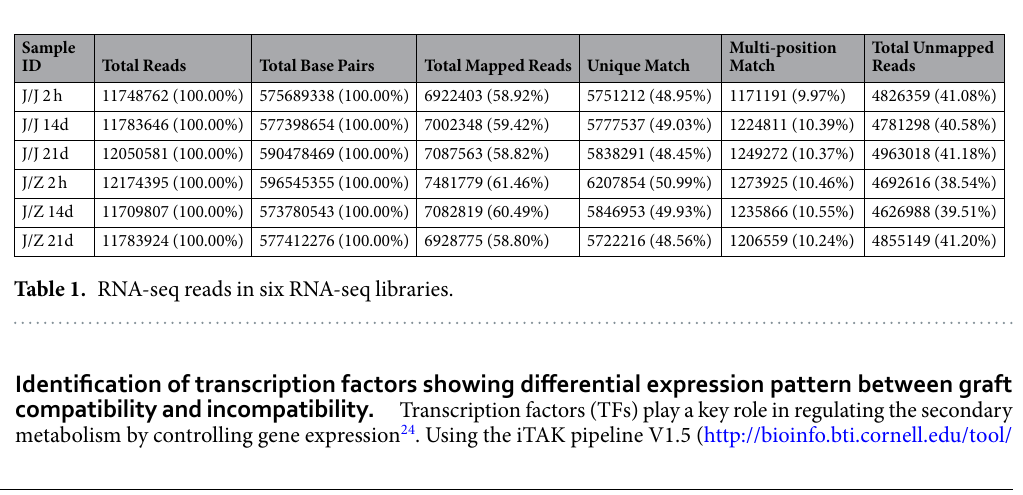
Identification of transcription factors showing differential expression pattern between graft compatibility and incompatibility. Transcription factors (TFs) play a key role in regulating the secondary metabolism by controlling gene expression 24 . Using the iTAK pipeline V1.5 (http://bioinfo.bti.cornell.edu/tool/